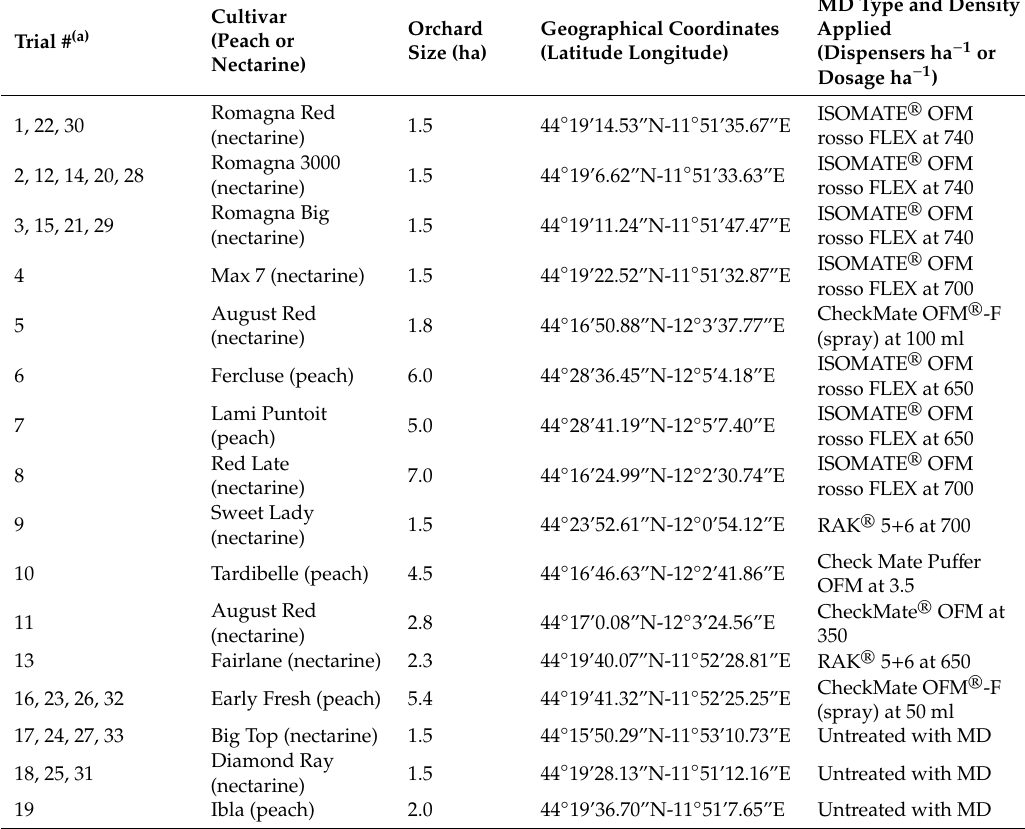
Table 2. Trial locations and Mating Disruption (MD) information for the sixteen peach and nectarine orchards in which the thirty-three lure comparison trials on Grapholita molesta monitoring were conducted. Trials from #1 to #13 were run in 2018, trials from #14 to #33 were run in